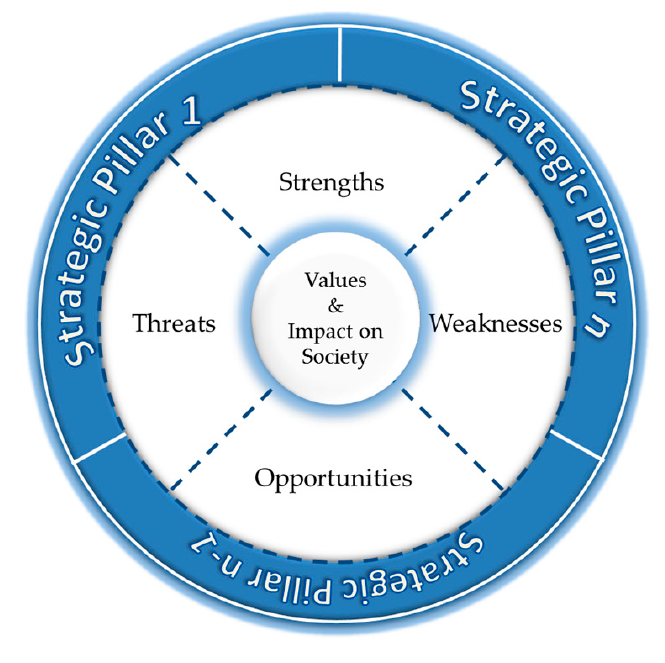
Figure 13. SWOT i.